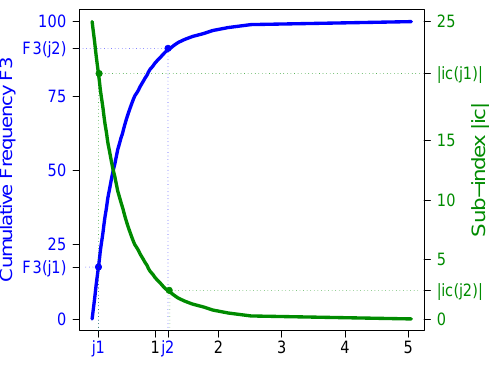
Fig. 4. Cumulative frequency (%) of geostrophic circulation error (in CU), F 3 (in blue), and partial index, | ic | (in green).